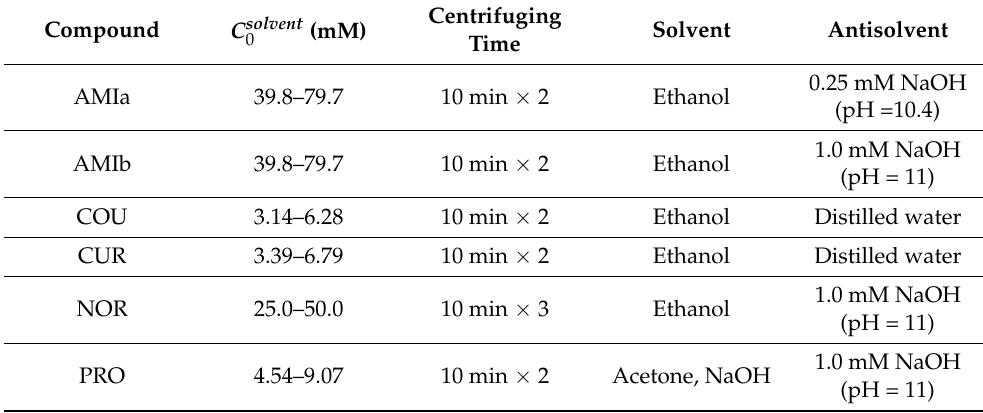
Table 1. Compound concentration in the solvent solution ( C solvent and the solvent and antisolvent used for each of the compounds investigated in the present study.